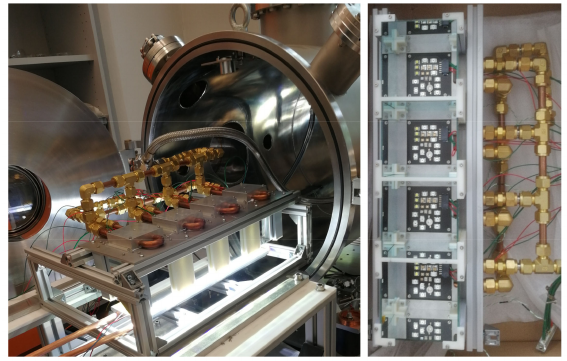
Figure 5. Left: SoSi in front of vacuum chamber; right: Four LED clusters and light guides; liquid cooling system for the